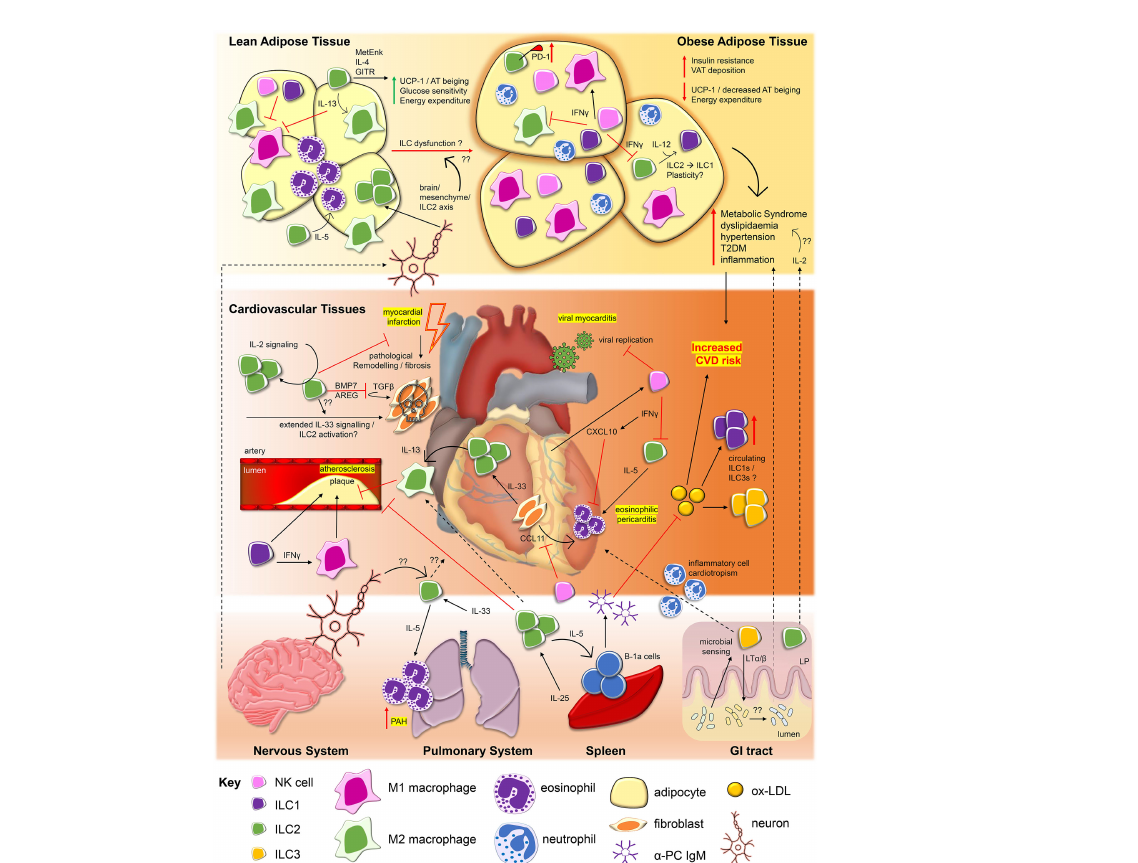
FIGURE 1 | Innate lymphoid cells contribute to protective and pathological processes in cardiovascular diseases and obesity. During viral myocarditis caused by agents such as Coxsackie virus B3 ( CV-B3 ), NKs restrict viral replication (20) and are recruited to cardiac tissues by cardiomyocyte production of C-X-C motif chemokine ligand 10 ( CXCL10 ), itself promoted by NK-derived interferon gamma ( IFN g ) (21). IFN g may also restrict ILC2 activity, in fl uencing ILC2 capacity to drive in fl ammation associated with eosinophilic pericarditis. Interleukin ( IL )-33 derived from cardiac fi broblasts drives cardiac ILC2 proliferation and along with fi broblast production of eotaxins (i.e. eotaxin-1/ CCL11 ), ILC2 production of IL-5 may facilitate recruitment of eosinophils to the pericardium (9). ILC2 production of IL-13 can also promote polarisation of M2 macrophages, which may serve protective roles in atherosclerosis (12, 22). Conversely, ILC1s and promotion of classically activated proin fl ammatory M1 macrophages may promote atherosclerotic plaque formation (23 – 25). ILC2s, regulated by IL-2 signalling, may also serve protective roles for cardiac tissue repair following major adverse events such as myocardial infarction, via the production of amphiregulin (AREG) and bone morphogenic protein 7 ( BMP7 ), inhibiting pathological tissue remodelling and fi brosis (26). The impact of prolonged activation of ILC2s by factors such as IL-33 on the outcome of ILC2 repair responses in this context require further study (27). In the circulation, increased frequencies of ILC1s and ILC3s are associated with major cardiovascular and cerebrovascular events including ST-elevated myocardial infarction (STEMI) and acute cerebrovascular infarction (ACI/Stroke) (28, 29). This may be related to increased circulating levels of oxidised low-density lipoproteins ( ox-LDL ) in patients, but the impact of these alterations to ILC subset frequencies inpatients remain to be elucidated. Obesity , and its associated metabolic in fl ammation is associated with major risk factors for the development of CVDs, including type 2 diabetes mellitus ( T2DM ), dyslipidaemia, hypertension, and in fl ammation. As observed in cardiovascular tissues, ILC2s are the dominant ILC subtype found within lean adipose tissue . ILC2s promote alternatively activated M2 macrophage phenotypes and eosinophils within adipose tissue via their production of IL-5 and IL-13, contributing to lean adipose tissue homeostasis (30 – 33). ILC2 expression of methionine enkephalin ( MetEnk ) (31) and IL-4 (34), in addition to signaling via Glucocorticoid-induced TNFR-related protein ( GITR ) (32) can protect from obesity by promoting beiging of white adipose tissue, linked to upregulation of mitochondrial uncoupling protein 1 (UCP-1), increasing glucose sensitivity and energy expenditure. In obese adipose tissue ILC2 numbers and functions are impaired, contributing to increased visceral adipose tissue ( VAT ) depots, insulin resistance and decreased beiging. Upregulation of inhibitory receptor PD-1 by ILC2s (35), negative regulation by IFN g derived from ILC1s and natural killer cells (NKs) (36, 37), and ILC2 to ILC1 conversion (38) may be among the mechanisms which result in ILC2 dysfunction in obesity. NKs and ILC1s numbers are also altered in obesity, potentially impacting upon the ratio between in fl ammatory M1 and anti-in fl ammatory M2 macrophages (33, 39). In fl uences from physiological signals and ILCs present in other tissues may also impact upon CVDs and obesity pathogenesis. The nervous system can regulate ILC2 activity within lean adipose tissue via a brain/mesenchymal/ILC2 axis (40). Dysregulation of this axis may contribute to development of obesity, however, broader effects of neuronal signalling on ILCs in the context of CVDs requires further study. In the induction of pulmonary arterial hypertension ( PAH ), IL-5 derived from pulmonary system ILC2s are responsible for tissue eosinophilia which may drive arterial damage (41). IL-25 drives ILC2 proliferation in the spleen , promoting atheroprotective effects, IL-5-dependent B-1a expansion and production of anti- phosphorylcholine (PC) Immunoglobulin M ( IgM ) which targets ox-LDL (42, 43). In the gastrointestinal (GI) tract , sensing of microbial composition by ILC3s may in fl uence in fl ammatory cell cardiotropism in the context of myocarditis (44), while ILC2s and ILC3s within the intestinal lamina propria (LP) may also contribute to processes driving obesity, through factors such as production of IL-2